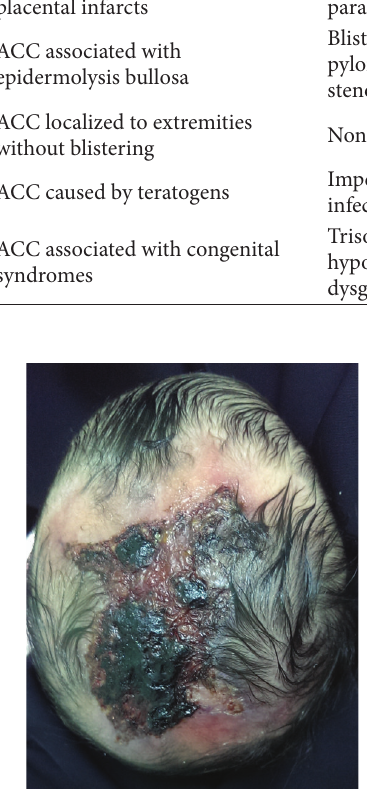
Figure 2: Six-month follow-up shows scar formation over the affected